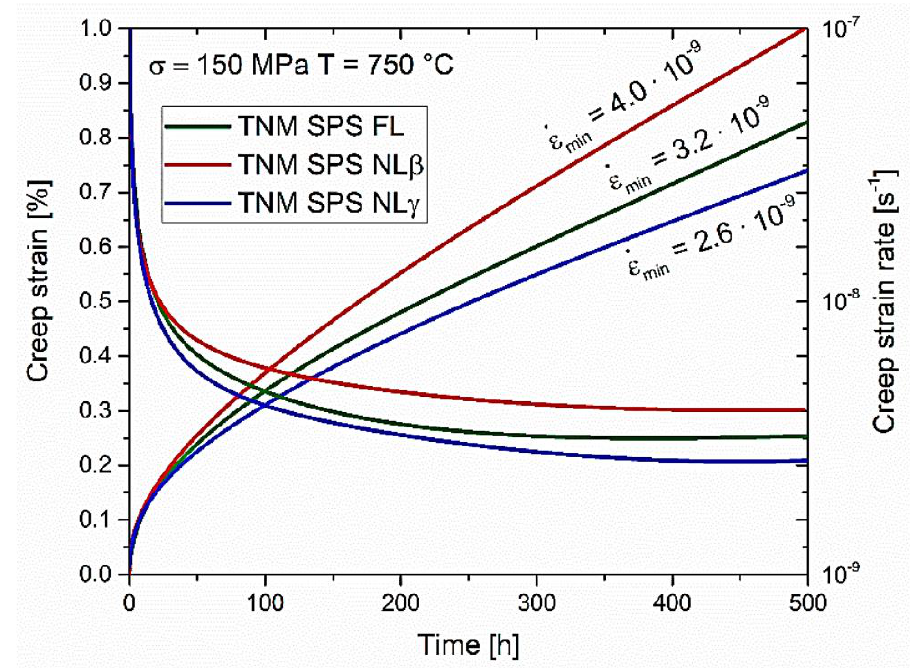
Figure 16. Plots of creep stress and strain versus time of the heat-treated microstructures tested at 750 °C and 150 MPa [141].